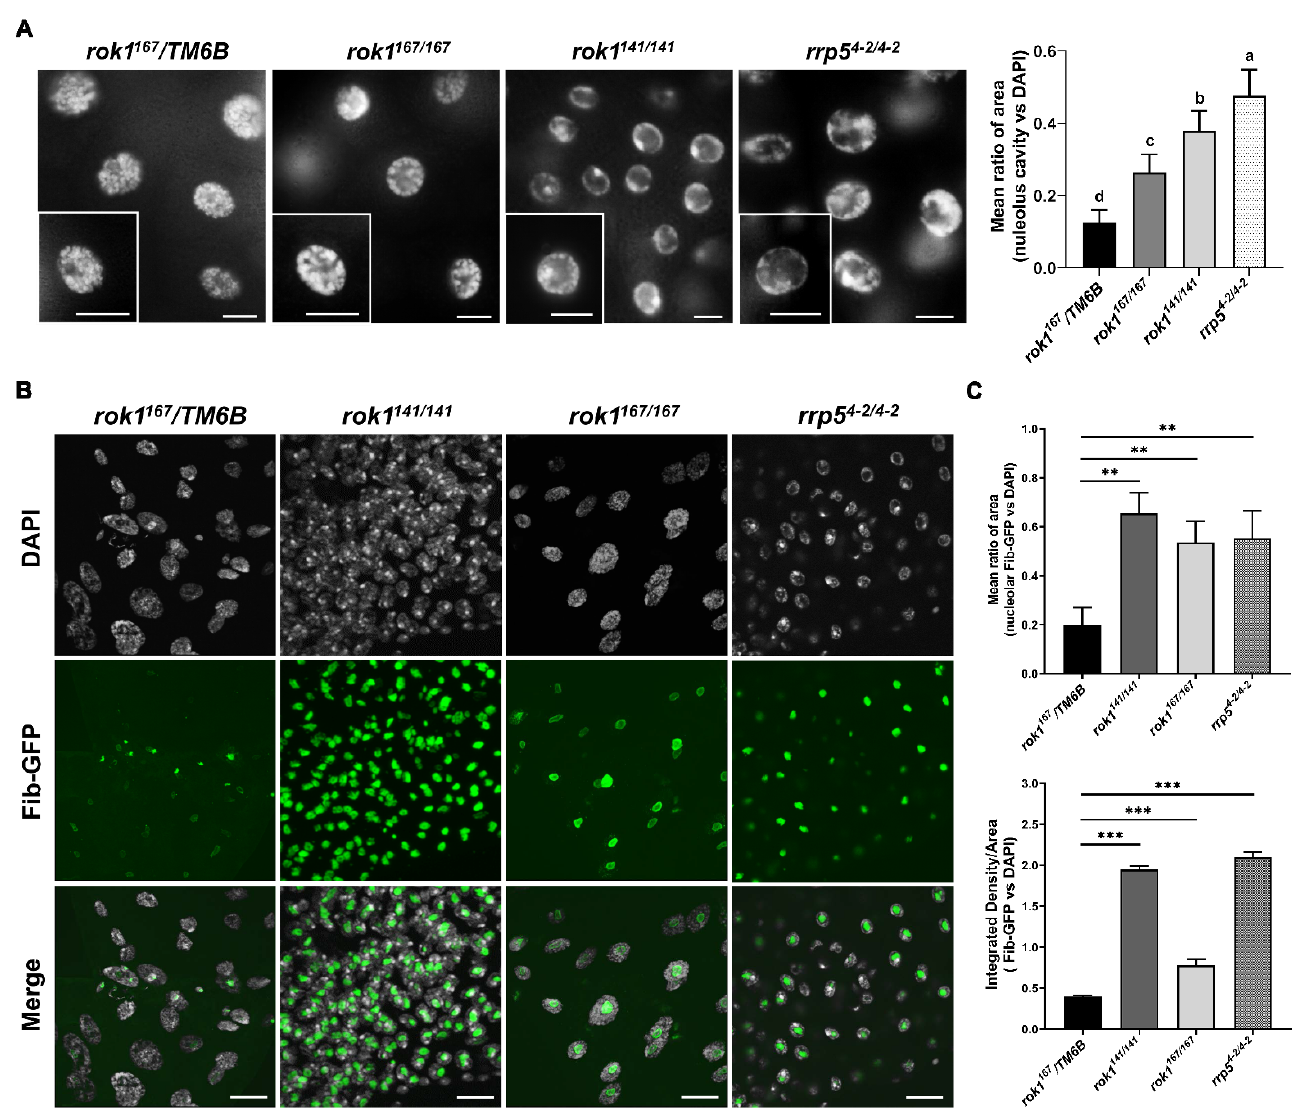
Figure 2. Loss of Rok1 and Rrp5 enlarges the nucleolus in D. melanogaster . ( A ) Nuclei from salivary glands in rok1 and rrp5 mutants. Salivary glands from second-instar larvae of rok1 141/141 and rrp5 4-2/4-2 , and third-instar larvae of rok1 167 /TM6B and rok1 167/167 were dissected, respectively. The nuclear genome is DAPI-stained. Scale bar represents 40 µ m. Amplified areas marked with solid rectangles are shown as inserts. Mean ratio of area from salivary gland cells for each genotype is provided in panels to the right. Each point represents the mean ± SD ( n = 35). Different letters indicate significant differences between areas in the various groups ( p < 0.05, LSR, SPSS). ( B ) Localization of Fib, a nucleolar marker, in salivary gland of rok1 and rrp5 mutants. Salivary glands from second-instar larvae of rok1 141/141 and rrp5 4-2/4-2 , and third-instar larvae of rok1 167 /TM6B and rok1 167/167 were dissected, respectively. Scale bar represents 40 µ m. ( C ) Mean ratio of area and fluorescence density of Fib-GFP in each genotype. Each point represents the mean ± SD ( n = 35, for area; n = 9, for density). ** and *** indicate significant differences between the two groups at the p < 0.01 and p < 0.001 levels, respectively (unpaired t -test, SPSS). Table 1. The lethal phenotypes of rok1 and rrp5 mutations.